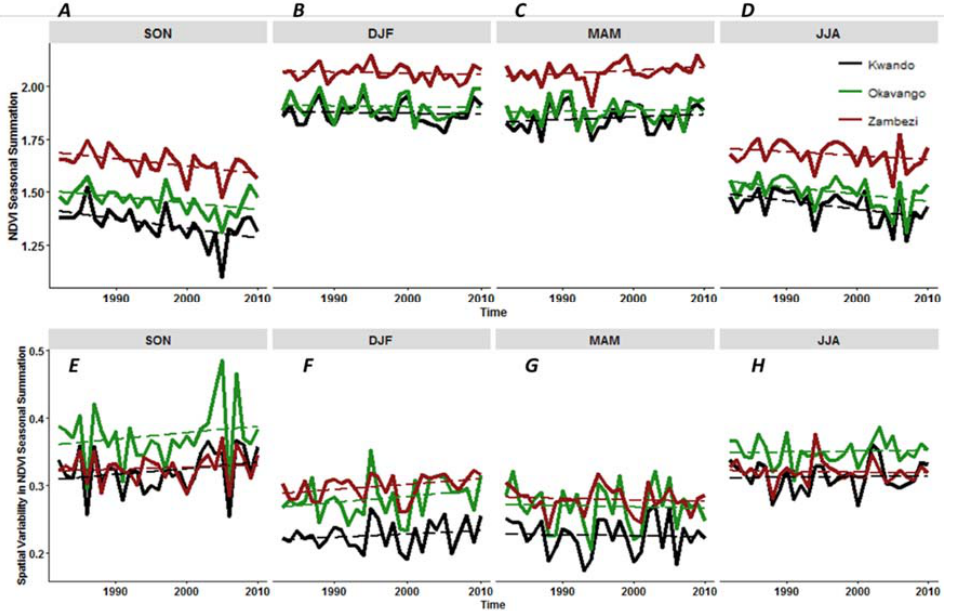
Figure 6. Seasonal (SON, DJF, MAM, JJA) NDVI totals ( A – D ) and standard deviations ( E – H ) across the Okavango, Kwando, and Zambezi from 1982–2010.